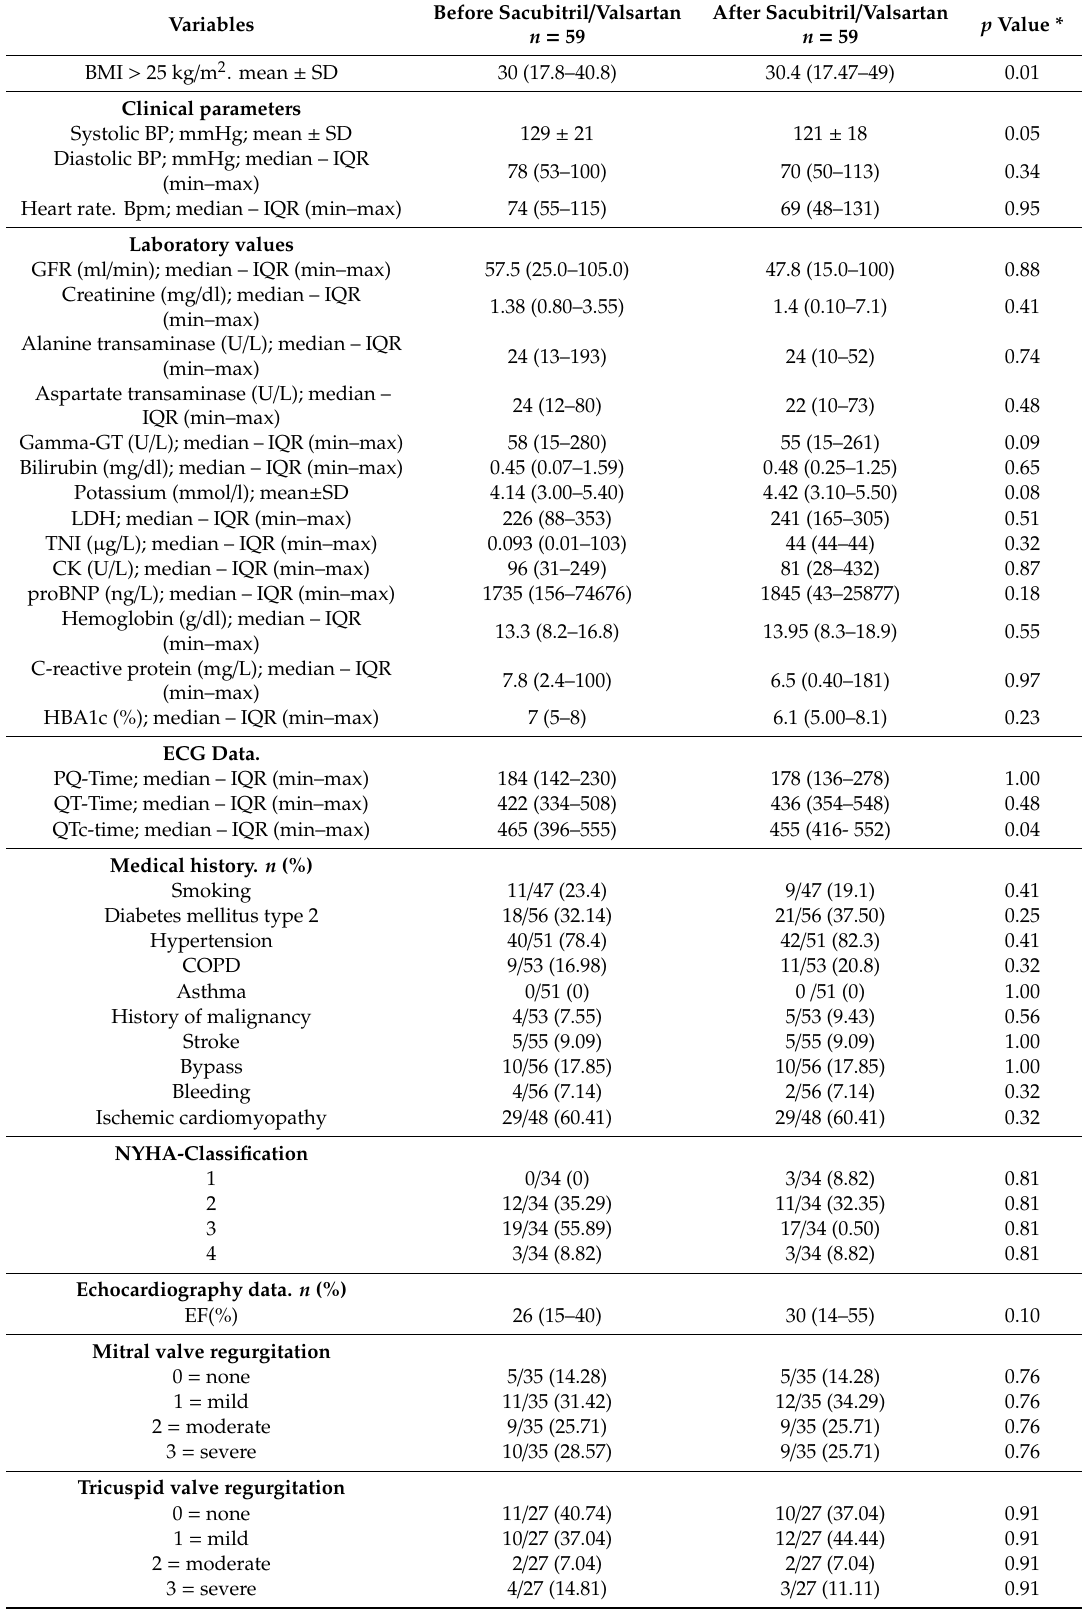
Table 3. Baseline characteristics of 59 patients initially presenting before and after sacubitril / valsartan. Before Sacubitril / Variables